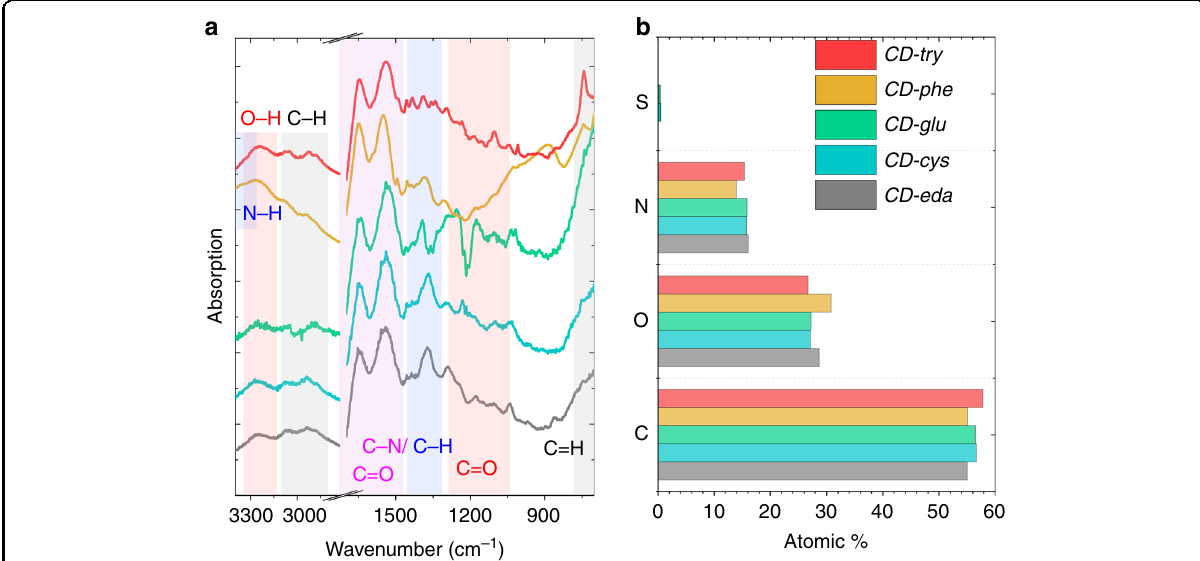
Fig. 3 Chemical compositions of fi ve CD samples. CD-eda (gray), CD-cys (cyan), CD-glu (green), CD-phe (orange), and CD-try (red). a FTIR spectra with characteristic peaks corresponding to different chemical bonds are highlighted in different colors; ( b ) atomic percentage of different chemical elements (C, O, N, S) constituting CDs, as derived from XPS